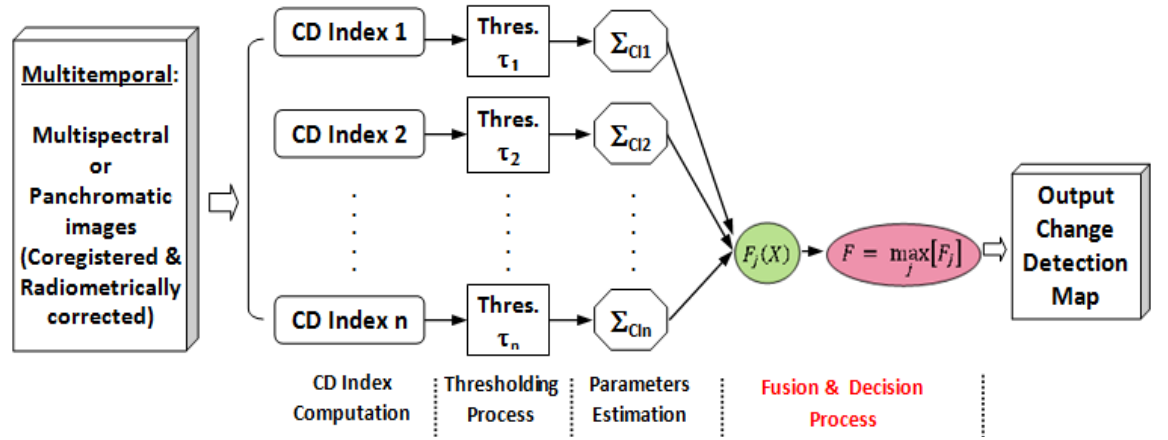
Figure 2. Methodological